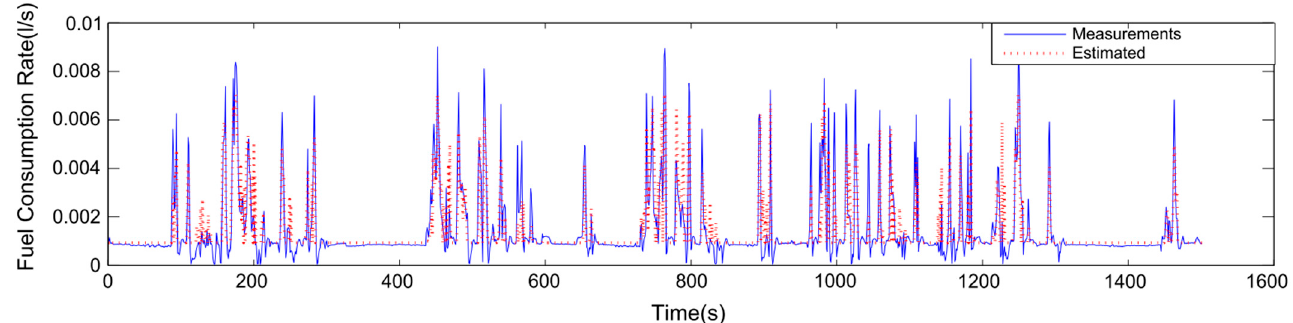
Figure 2. Model validation for bus fuel consumption model.